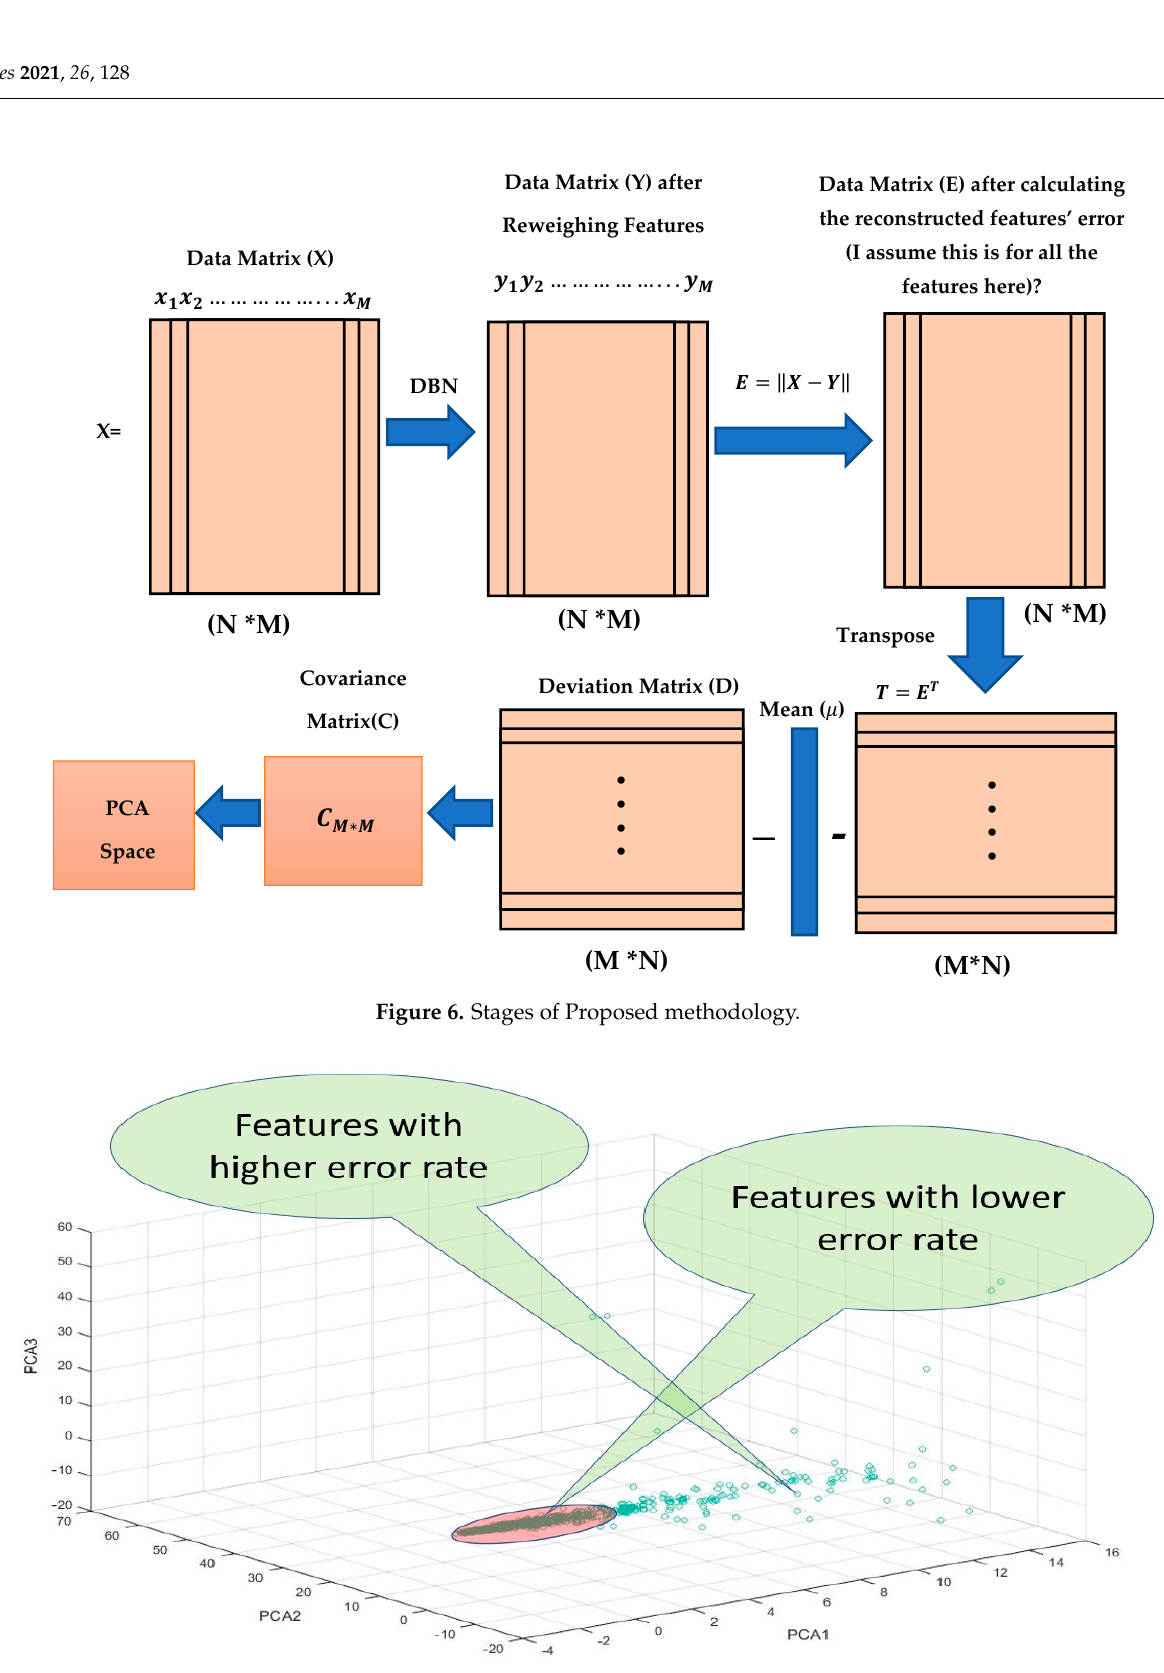
Figure 7. Principal component analysis (PCA) based reconstruction features error.